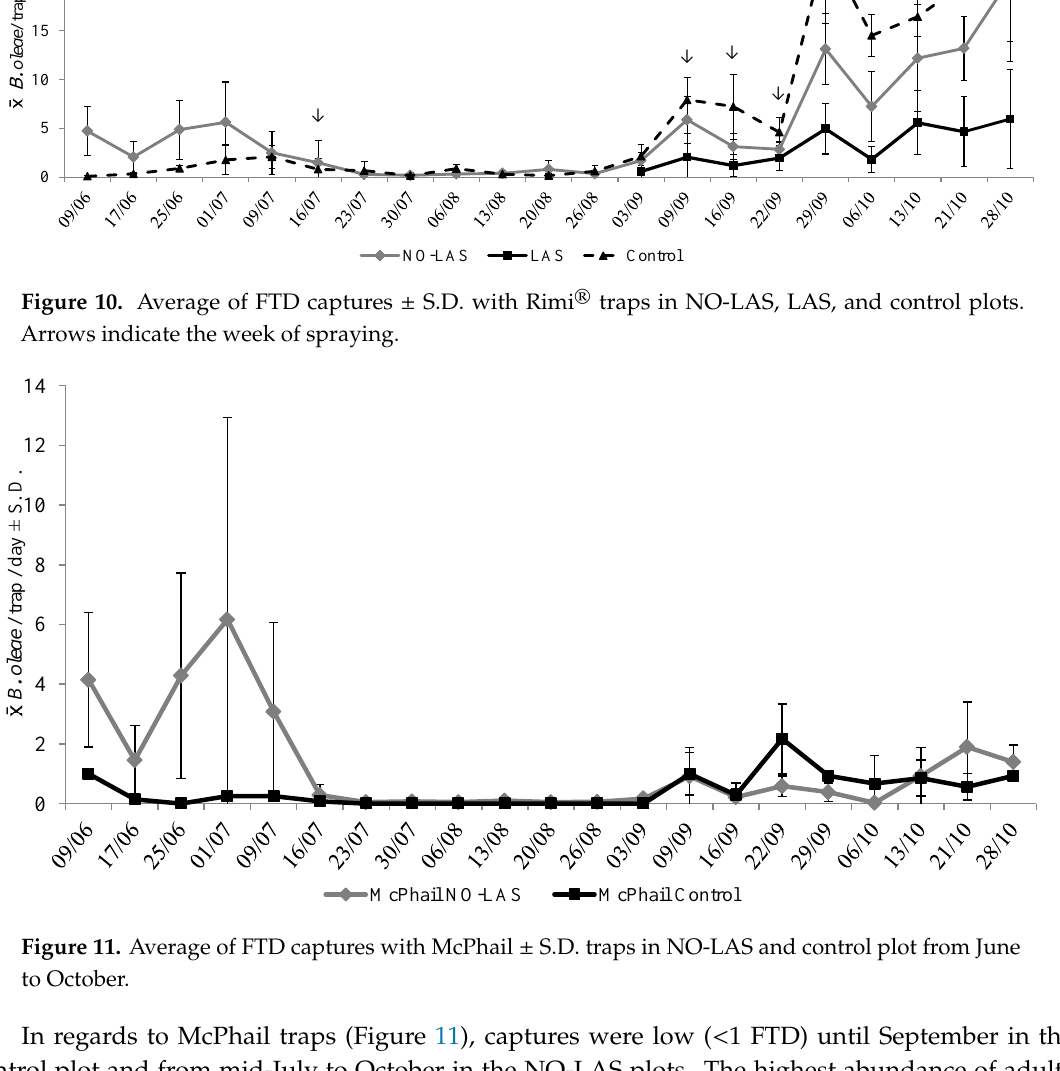
Figure 10. Average of FTD captures ± S.D. with Rimi ® traps in NO-LAS, LAS, and control plots. Arrows indicate the week of spraying.